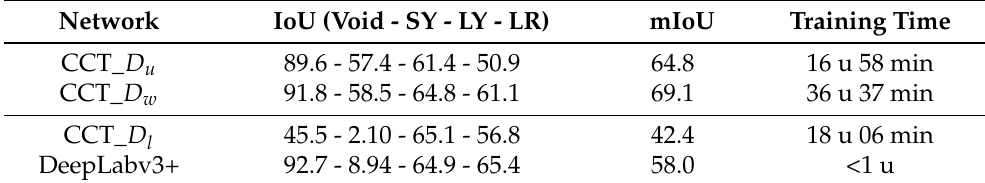
Table 4. Quantitative performance of the best performing CCT models trained semi-supervised using an unlabeled dataset (CCT_ D u ) and a weakly-labeled dataset (CCT_ D w ) compared to two baseline models (CCT_ D l and DeepLab_ D l ), evaluated on D v